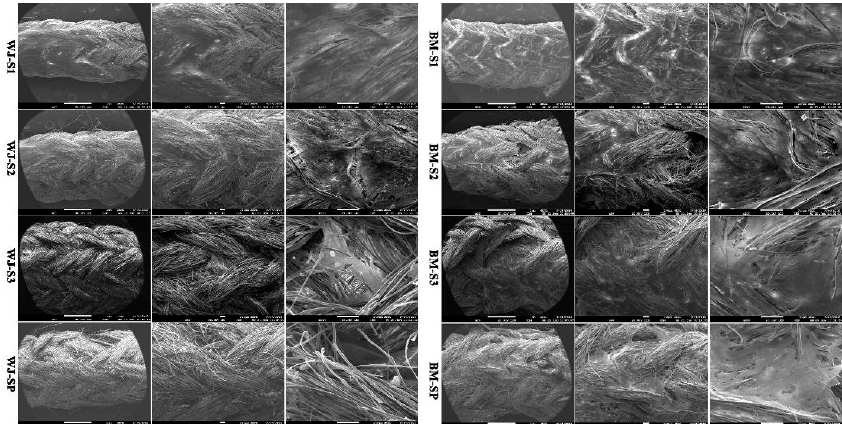
Figure 3. SEM global observations of cellular distribution on S1, S2, S3 and SP scaffolds for WJ-MSCs (left) and BM-MSCs (right).